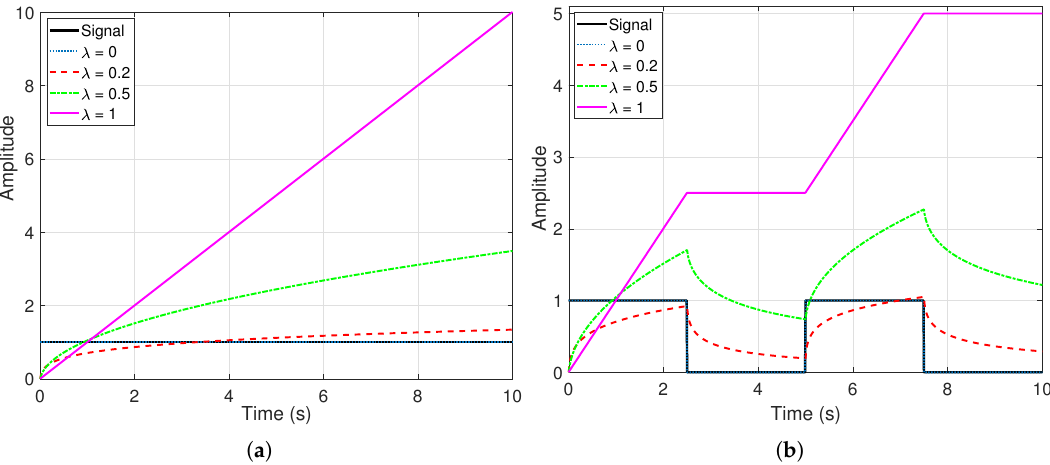
Figure 8. Effects of the integral action according to integration order λ on different error signals: ( a ) constant ( b ) square.